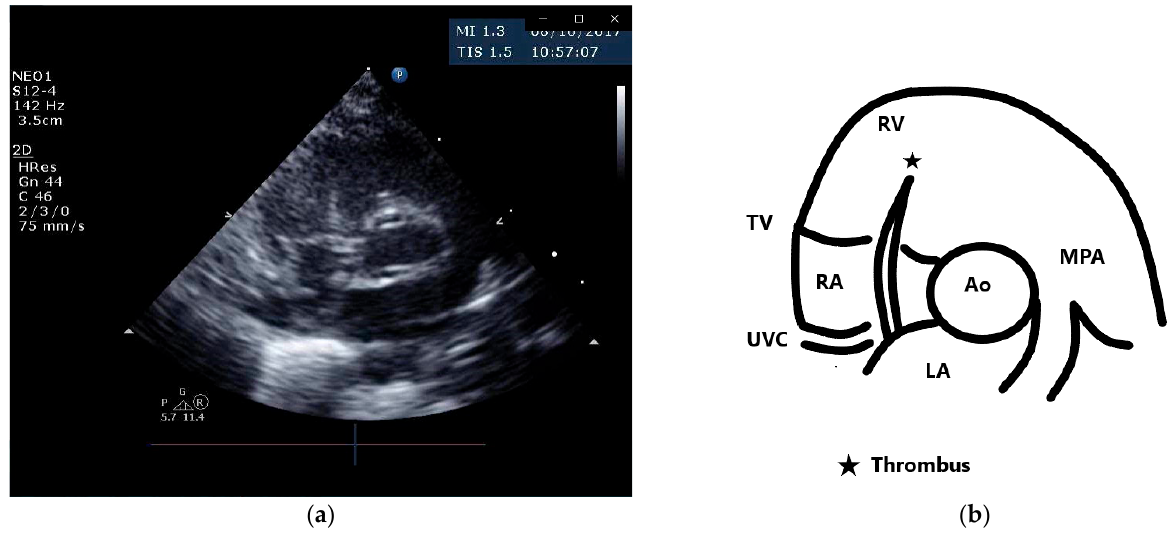
Figure 1. Parasternal short axis view and schematic drawing of the thrombus. ( a ) Short axis view showing the thrombus in the right atrium extending from the fossa ovalis and protruding to the inflow of the right ventricle; ( b ) schematic drawing of the echocardiographic view. Ao, aortic valve; MPA, main pulmonary artery; LA, left atrium; RA, right atrium; RV, right ventricle; TV, tricuspid valve; UVC, umbilical venous catheter.